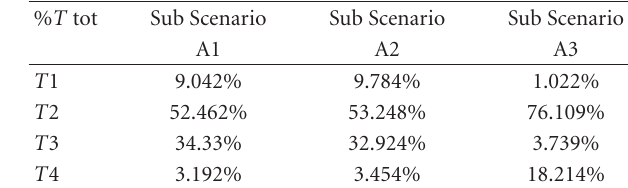
Table 4: Scenario A–BE time measurements (milliseconds).